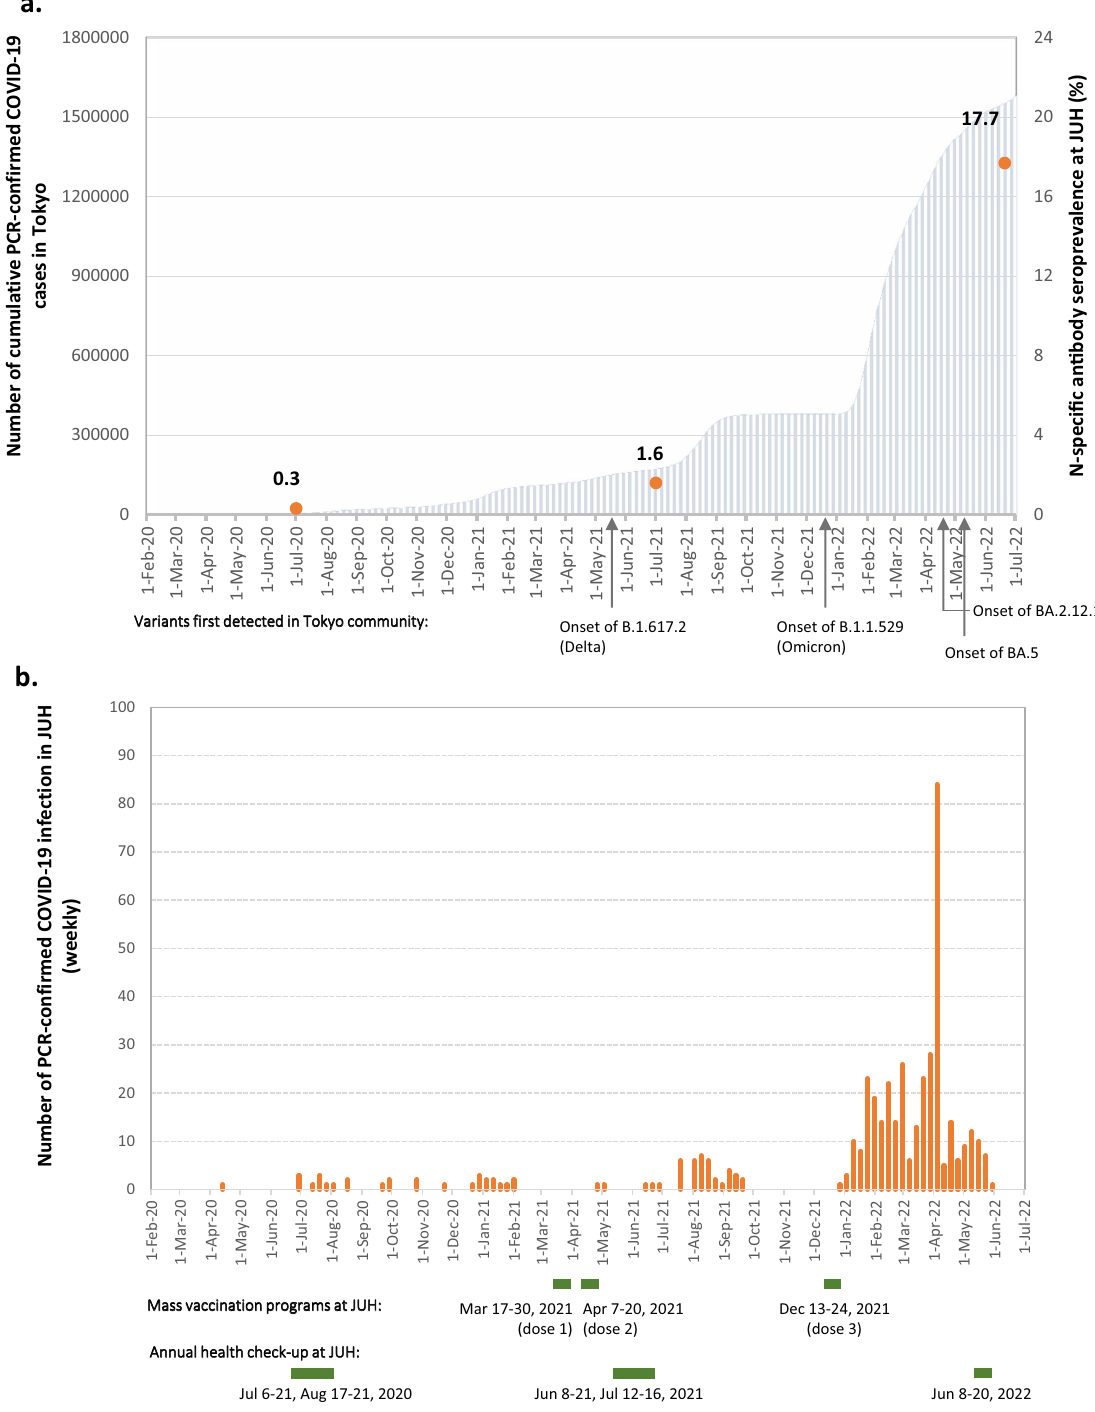
Figure 1. Infection rate at JUH with respect to the cumulative confirmed COVID-19 cases in the Tokyo metropolitan area. The number of PCR-confirmed COVID-19 infection cases until May 30, 2022 at JUH, including two participants with two positive PCR tests respectively—one on July 19 and September 11, 2020 and another on July 22, 2021 and January 28, 2022. Infection rates at JUH were calculated by the number of HCWs who were N-specific antibody-positive divided by the number of HCWs who participated in the annual health check-ups and gave consent for serological analysis. B.1.617.2 (Delta) 14 , B.1.1.529 (Omicron) 15 , BA.2.12.13 16 , and BA.53 16 were detected via implementing variant screenings in Tokyo community. Mass vaccination programs were conducted for all JUH’s HCWs who were willing to receive COVID-19 vaccines. Although the majority of HCWs received vaccines during the campaign periods, some might have individually received them